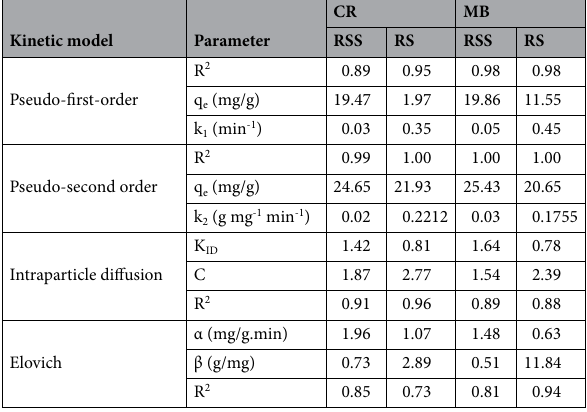
Table 1. The correlation coefficient, R 2 of pseudo-first and pseudo-second orders of RS and RSS.